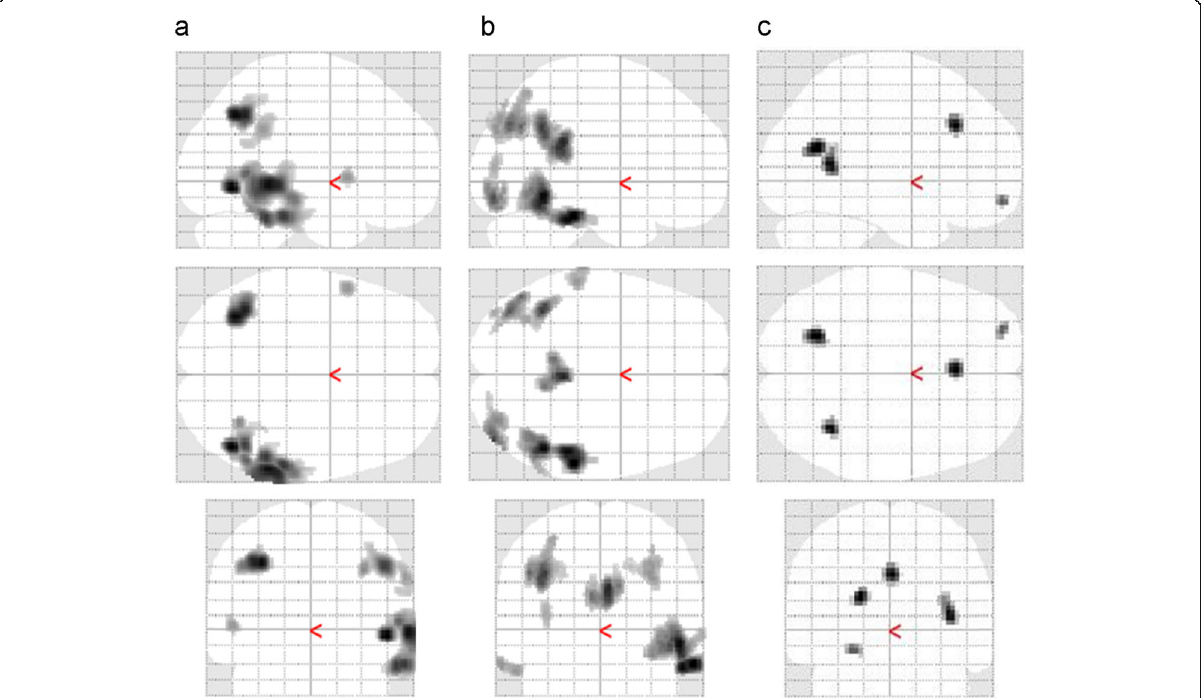
Fig. 2 SPM comparison of AD and CTL groups for PET- ( a ) and ASL-CBF ( b ), and RS-fMRI ( c ). All subject data of 27 AD and 16 CTL were applied in PET-CBF analysis, but only 25 AD datasets could be used for ASL-CBF comparison because of poor image quality due to artifacts. SPM analysis showed similar results of CBF reduction in AD group for both PET- and ASL-CBF comparison. Note the difference in the posterior cingulate cortex was observed only in the ASL-CBF analysis. RS-fMRI analysis showed significant decreases in the AD group in the anterior cingulate cortex and in the inferior part of the left precuneus ( P < 0.005, cluster-level P uncorr < 0.05). No significant increases were observed in AD for all parameters